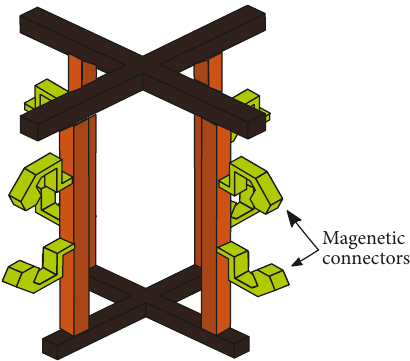
Figure 4: Model diagram of X-Bot MSRR.